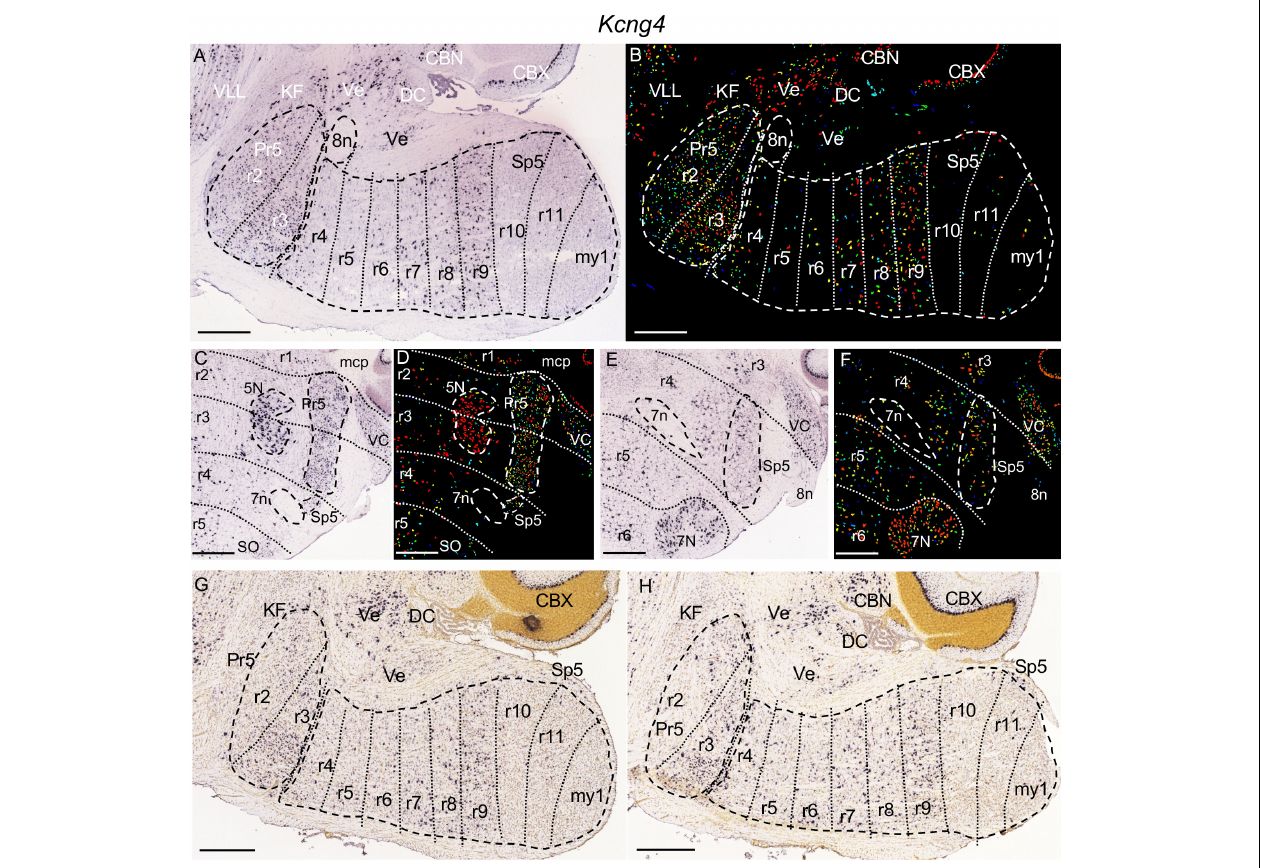
FIGURE 6 | Kcng4 expression. (A,B) Brightfield and color-coded images from a parasagittal section from an adult brain. Pr5 and Sp5, as well as the 8n bundle, are, respectively, encircled by dashed lines. There is homogenous expression within the r2 and r3 portions of Pr5, as well as the r9 portion of Sp5. From r9 the expression extends gradientally into the r8 and r7 portions of Sp5. There are also some disperse labeled cells within the r4, r5 and r6 portions of Sp5. Outside the trigeminal territory, in the brainstem this gene is expressed in KF, DC and vestibular nuclei (Ve). (C,D) Brightfield and color-coded images of a coronal section from an adult brain at the level of 5N. This nucleus, as well as Pr5, Sp5 and 7n are, respectively, encircled by dashed lines. There is dense and homogenous expression within the r2 and r3 portions of Pr5. The r4 portion of Sp5, adjacent to 7n, has some labeled cells. (E,F) Brightfield and color-coded images of a coronal section from an adult brain at the level of 7N. The limits of r4 are tentatively drawn enclosing the positions of the intraencephalic portion of 7n and the entry root of 8n. The r4 portion of Sp5 displays some labeled cells. This gene shows also expression in 5N and 7N as well as in VC. (G,H) Brightfield images of parasagittal sections, respectively, from P14 (G) and P28 (H) brains. There is Kcng4 expression in Pr5, although in the r2 portion of this nucleus the labeled cells are located only in its dorsal region. Within Sp5 the expression pattern from r4 to r9 is similar to that described for the adult brain. Scale bars = 500 µ